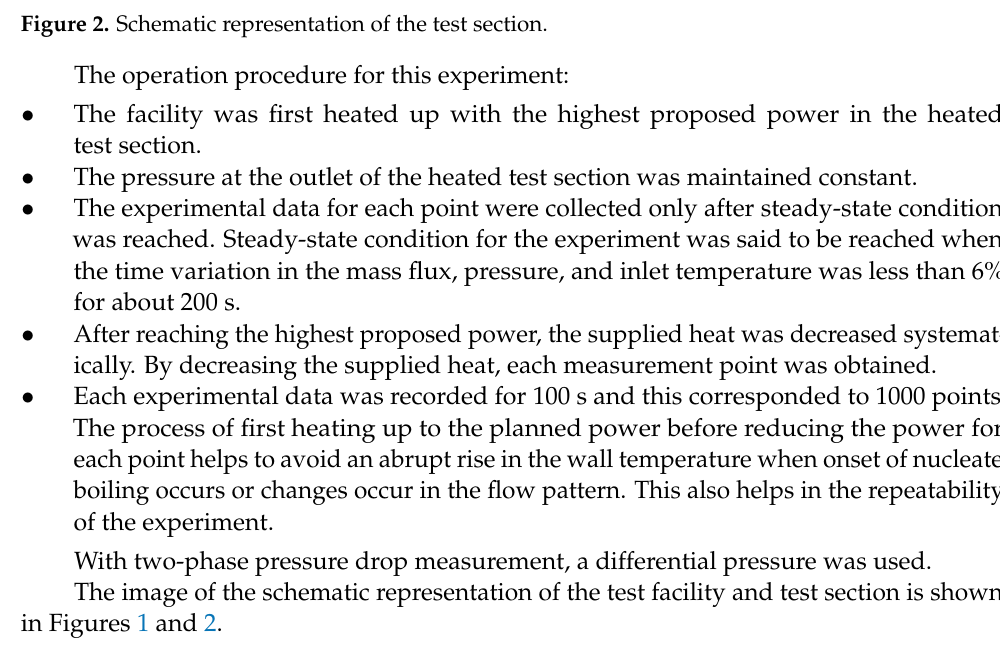
Table 2 . Measurement accuracy .